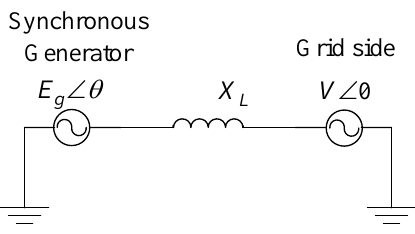
Figure 1. A simplified diagram of a synchronous machine connected to the grid via a line, X L .